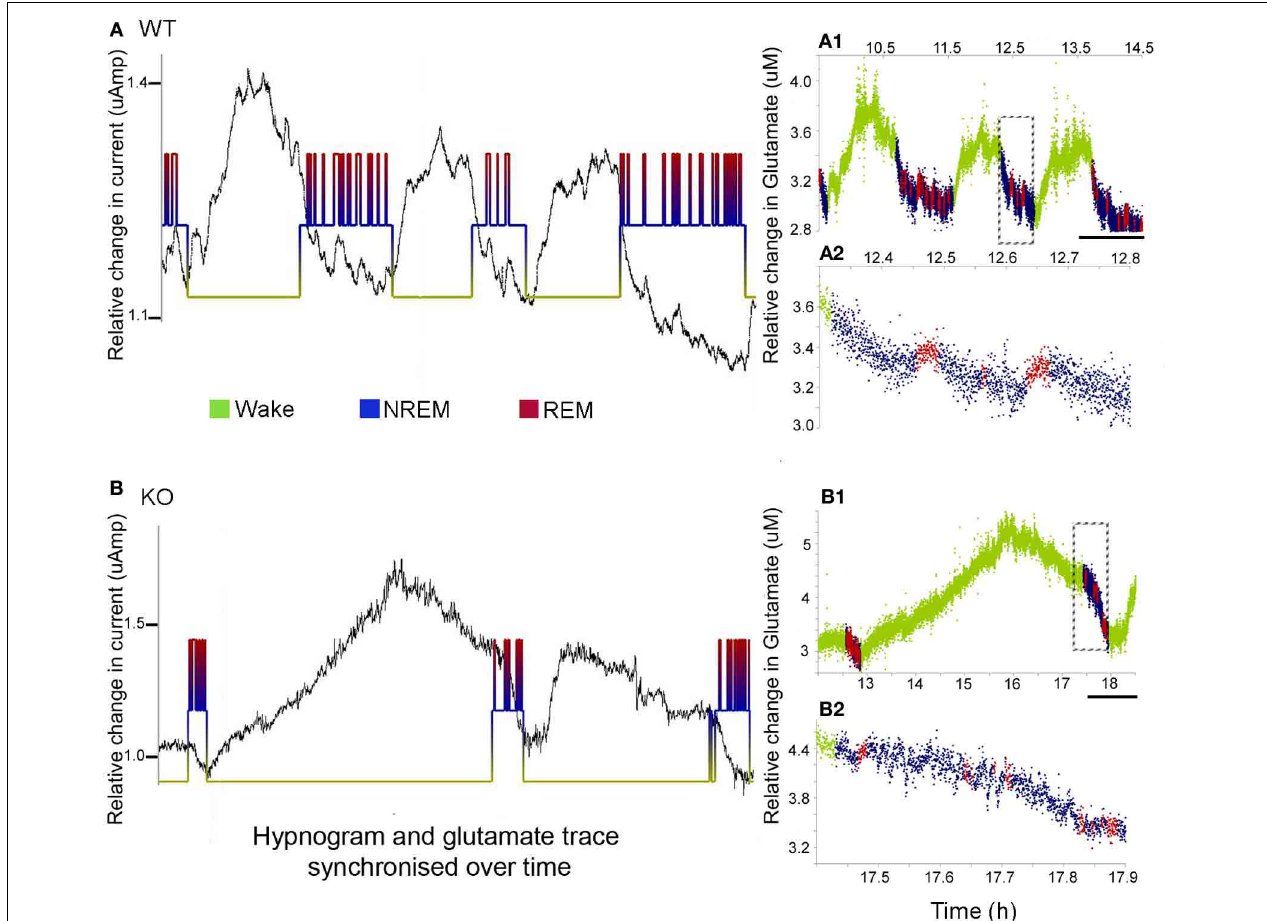
FIGURE 4 | Sleep cycle dysfunction and glutamate loads. (A,B) show the synchronous and relative glutamate change associated with the EEG/EMG and video scored hypnograms for representative WT and KO mice respectively [raw glutamate in-vivo recording (black) overriding hypnograms (green = wake, blue = NREM, and red = REM) for each mouse]. Both groups showed an activity dependent increase in glutamate during the wake cycle and a decrease during the sleep scored EEG.